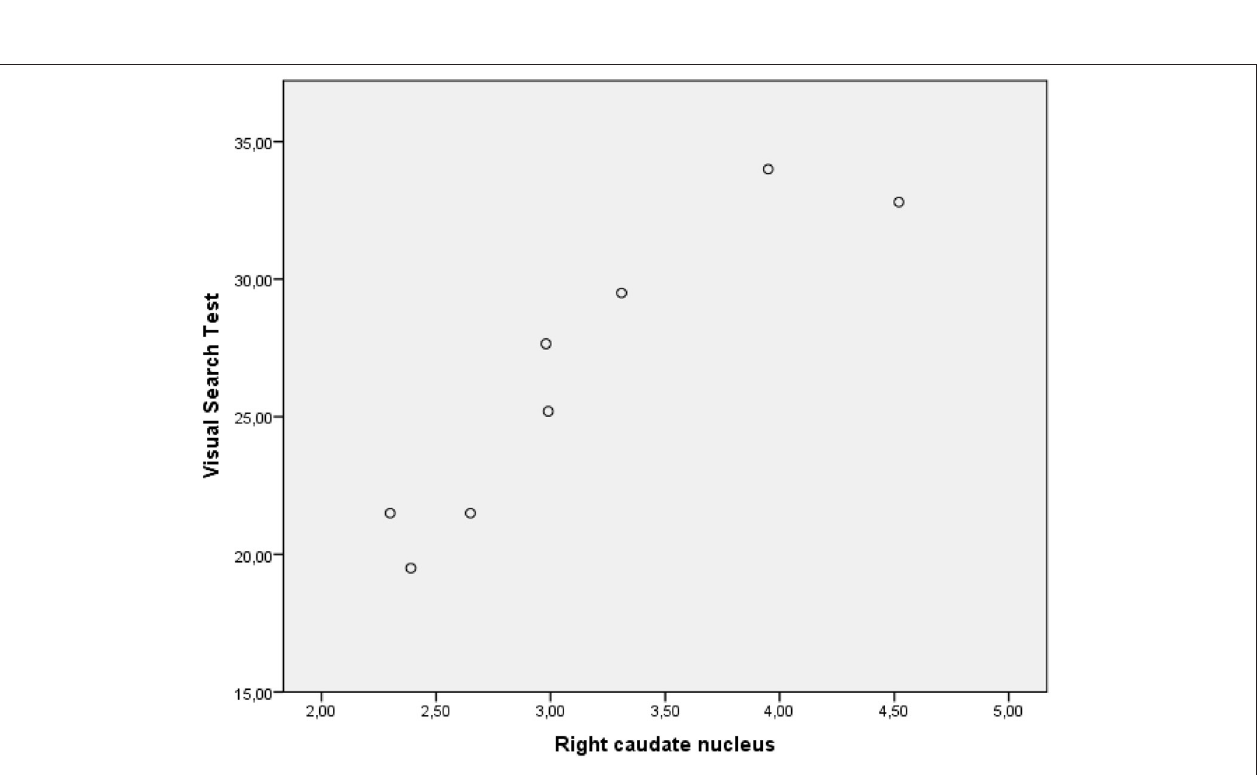
Frontiers in Psychology |